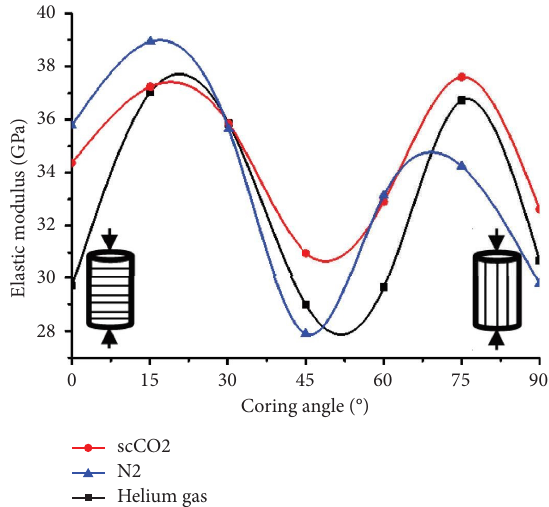
Figure 13: Fracture surface morphology of a typical shearing mode at the coring angle of 60 ° and 75 ° (the left specimen is from the scCO group; the right one is from the N 2 group). (a) 60 ° , (b) 70 ° .